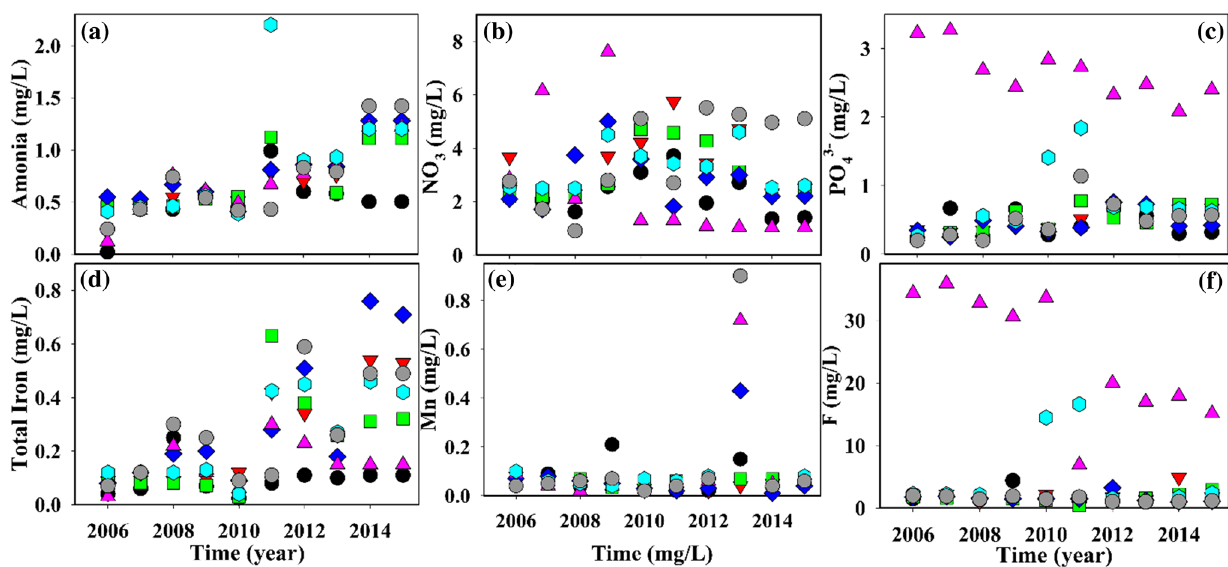
Fig. 6 Spatiotemporal variabilities of the concentrations of nutrients, minor ions, and trace metals in the Awash River and Lake